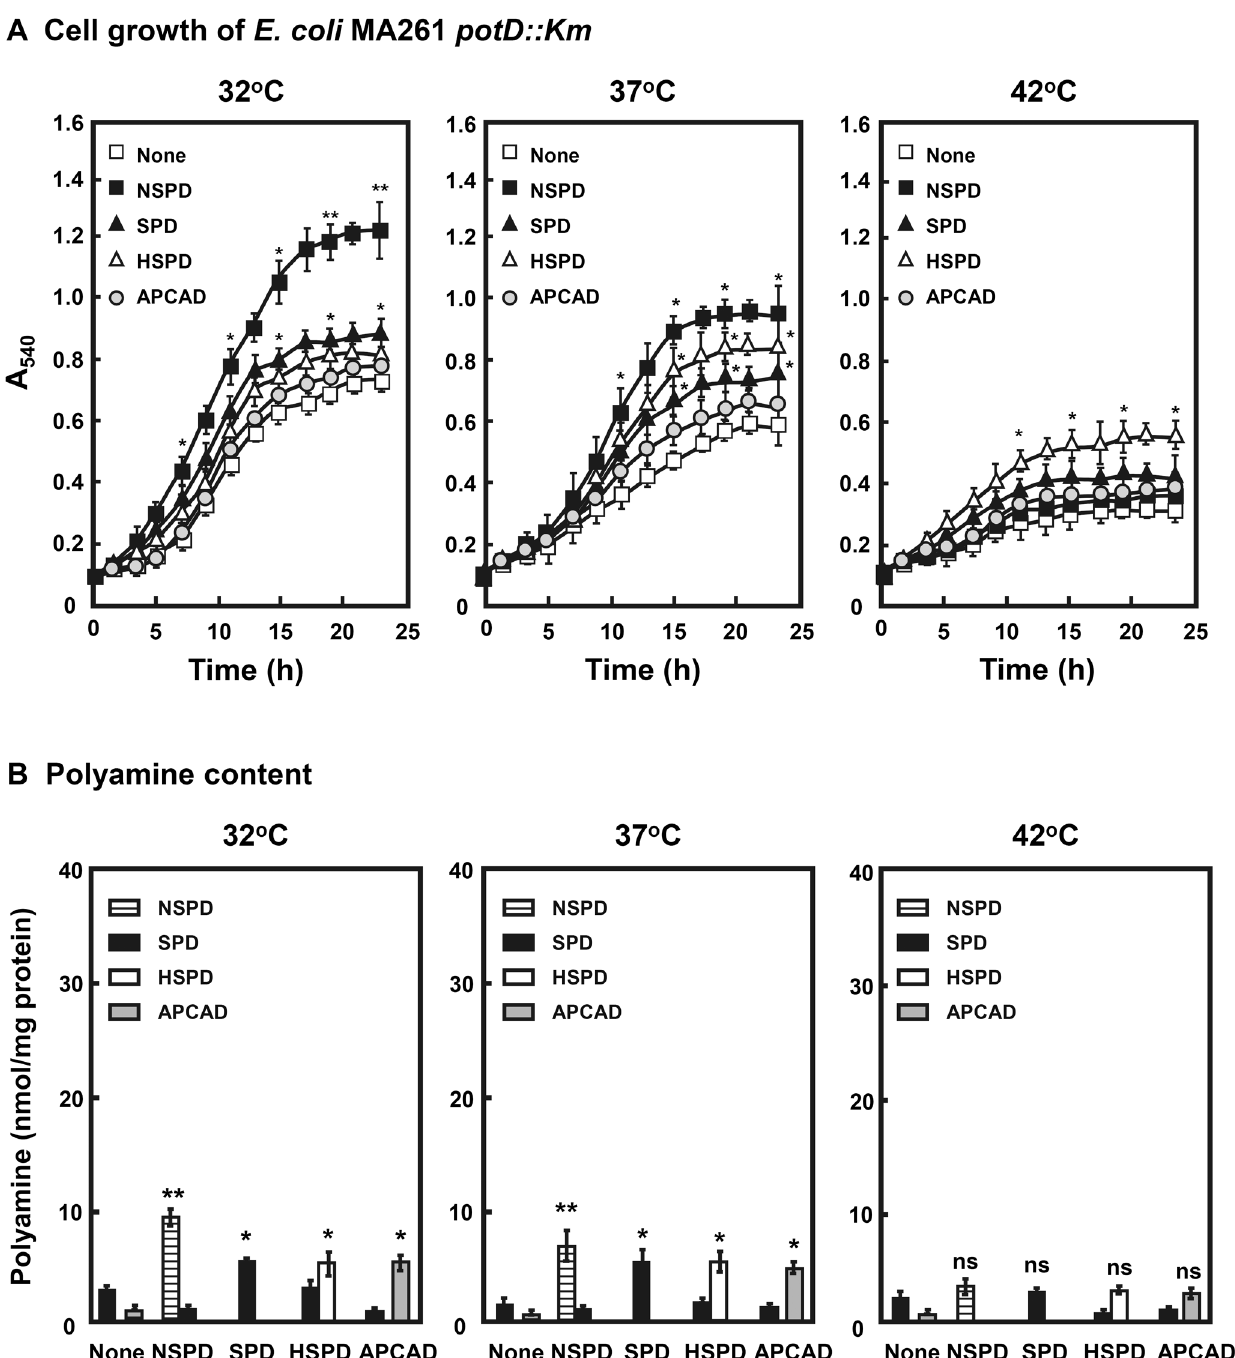
Fig 3. Effect of triamines on cell growth of E . coli MA261 potD :: Km . A and B. Cell growth of E . coli MA261 potD :: Km and polyamine content were measured as described in the legend of Fig 2. ns, p (cid:1) 0.05; * p < 0.05; ** p < 0.01.